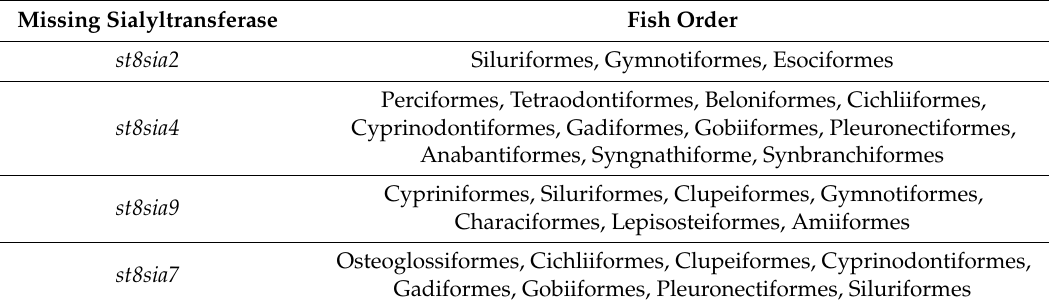
Figure 1. A schematic phylogenetic tree of vertebrate evolution. A simplified phylogenetic tree depicting the evolution of the jawed vertebrates Gnathostomes after the two rounds of whole genome duplication (WGD, R1 and R2). It is hypothesized here that WGD-R2 occurred after the Gnathostomes-Agnathes (jawless vertebrates) split. The Gnathostomes branch is divided into two categories: the cartilaginous fish Chondrychtyes (sharks and rays) and the bony fish Osteichthyes. The Osteichthyes are split into the lobe-finned fish Sarcopterygii that contain Tetrapods, and the ray-finned fish Actinopterygii that contain Neopterygii (Chondrostei, Holostei, and Teleosts). Table 1. Fish orders that have lost st8sia genes.